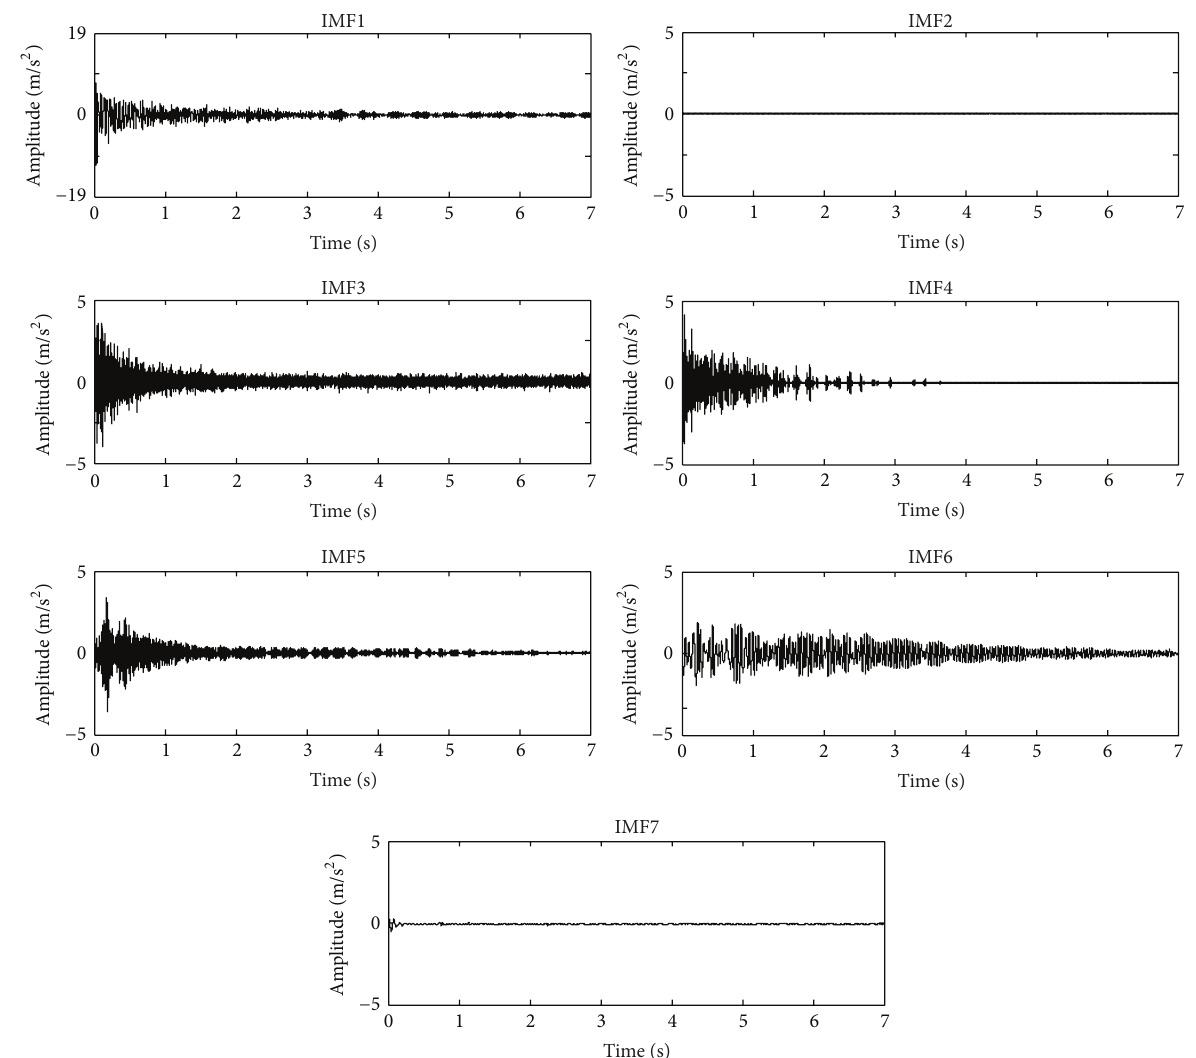
Figure 7: IMF obtained through EEMD for free vibration